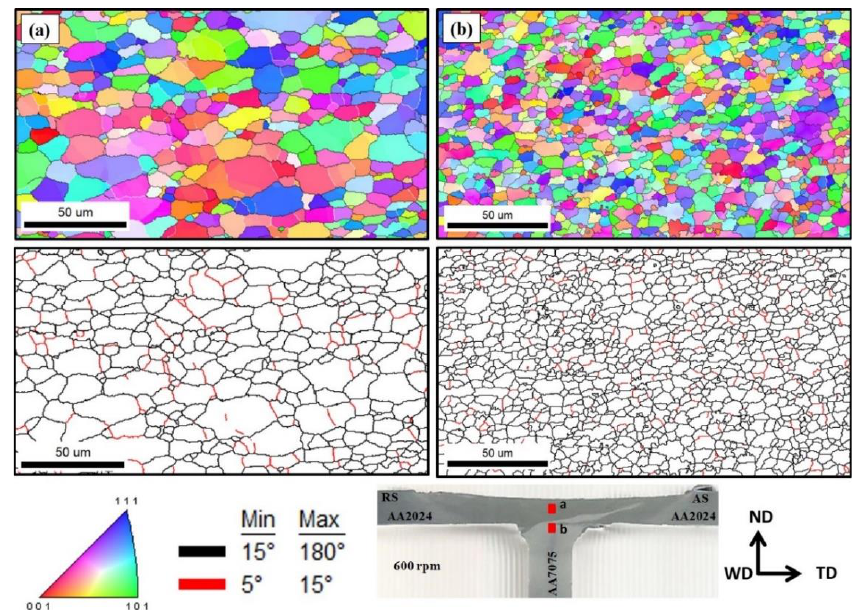
Figure 13. IPF coloring maps and their corresponding grain boundary maps for SZ of T-butt Friction stir welded joint AA2024-T4 and AA7075-T6 produced at 600 rpm, where ( a ) at AA2024-T4 region and ( b ) at AA7075-T6 region in the joint produced at 600 rpm. The positions at which the EBSD data collected are indicated with two red rectangles on the macrograph of the joint below the figure. The IPF maps key coloring, grain boundary legend and FSW axes are also presented below the